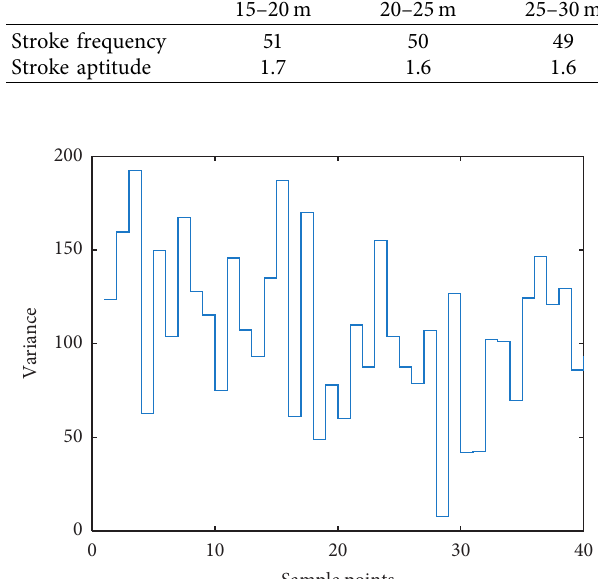
Figure 9: Data stability after multiround training of the